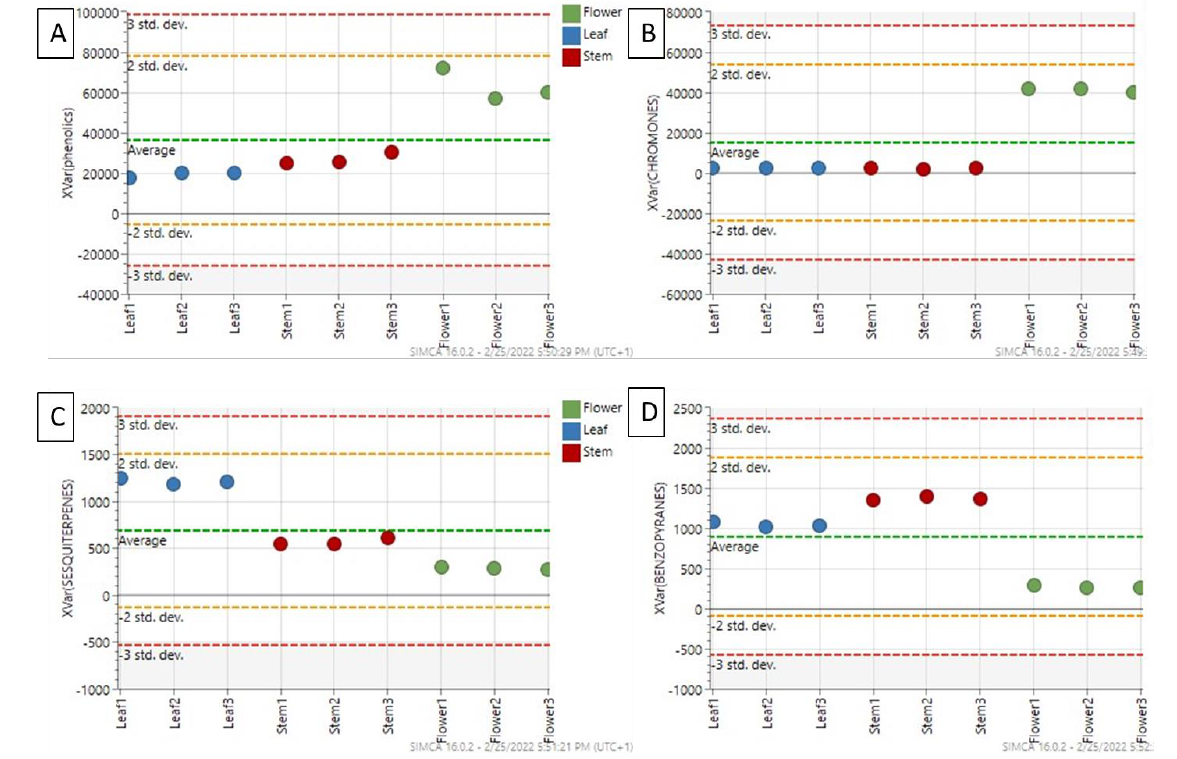
Figure 4. Variable trend plots of the most discriminant metabolite classes: phenolics ( A ) and chromones ( B ) are overexpressed in the flowers, while sesquiterpenes ( C ) and benzopyrans ( D ) markers had the highest influence to discriminate leaves and stems.